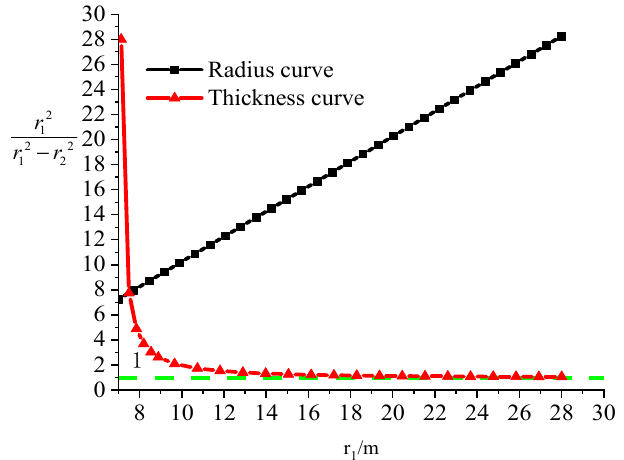
Figure 7. Radius coefficient changes with radius and thickness of the tunnel lining.